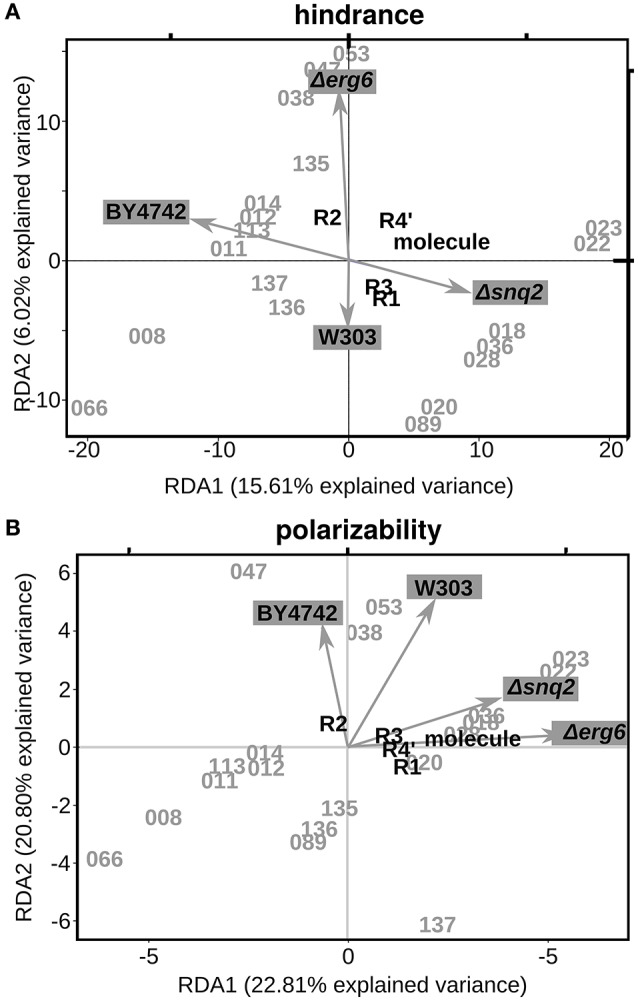
Relationship between steric hindrance or polarizability and the phenotypic effects. (A) First two explanatory components identified with the Redundancy Analysis (RDA) on ΔODst % values and steric hindrances. RDA1, First RDA constrained axis; RDA2, Second RDA constrained axis. The ΔODst % calculated for every strain treatment were used as constraining variables; as explanatory variables we used the steric hindrance values (A3) calculated with the Marvin Sketch software (5.10.0). (B) First two explanatory components identified with RDA on ΔODst % values and molecule/substituent polarizability. The ΔODst % calculated for every strain treatment were used as constraining variables; as explanatory variables we used the polarizability indexes (A3) calculated with the Marvin Sketch software (5.10.0).